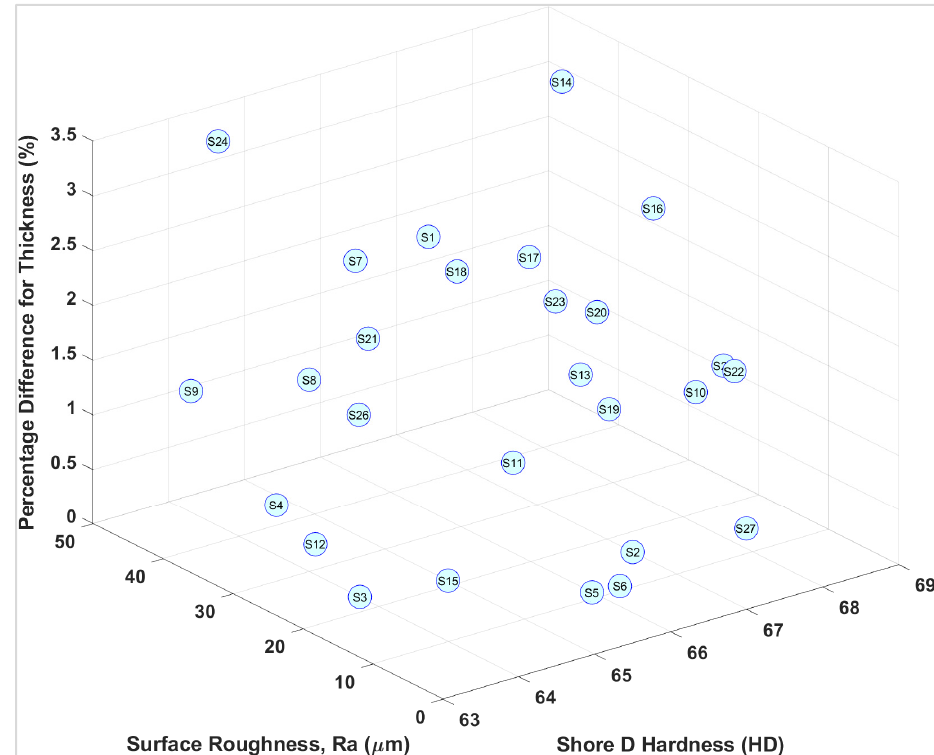
Figure 9. Three-axis plot for ABS material.